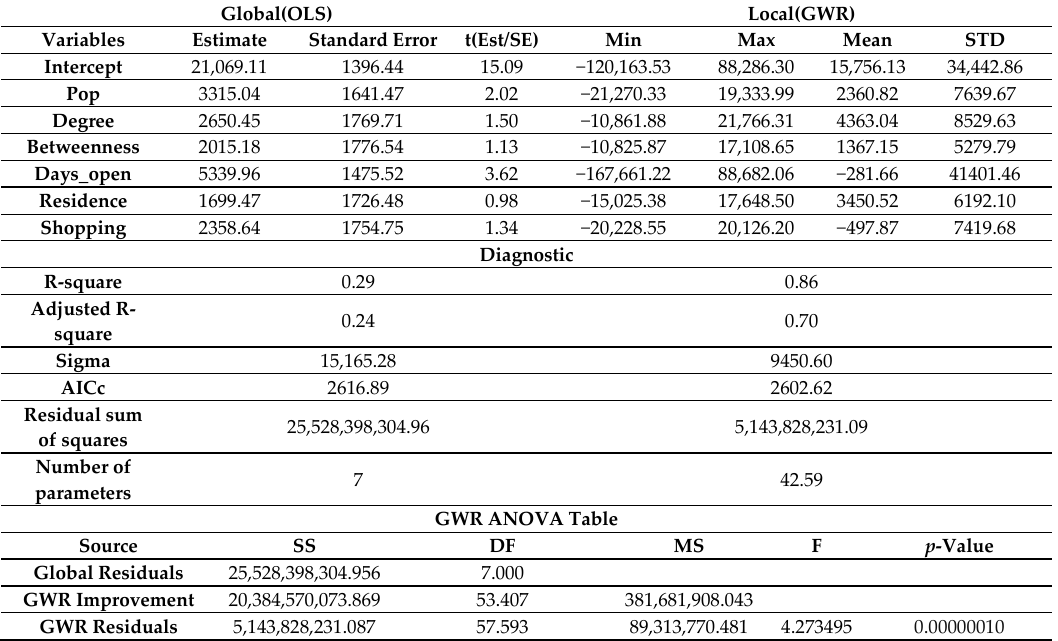
Table A3. Results of the model for Weekend_ridership.